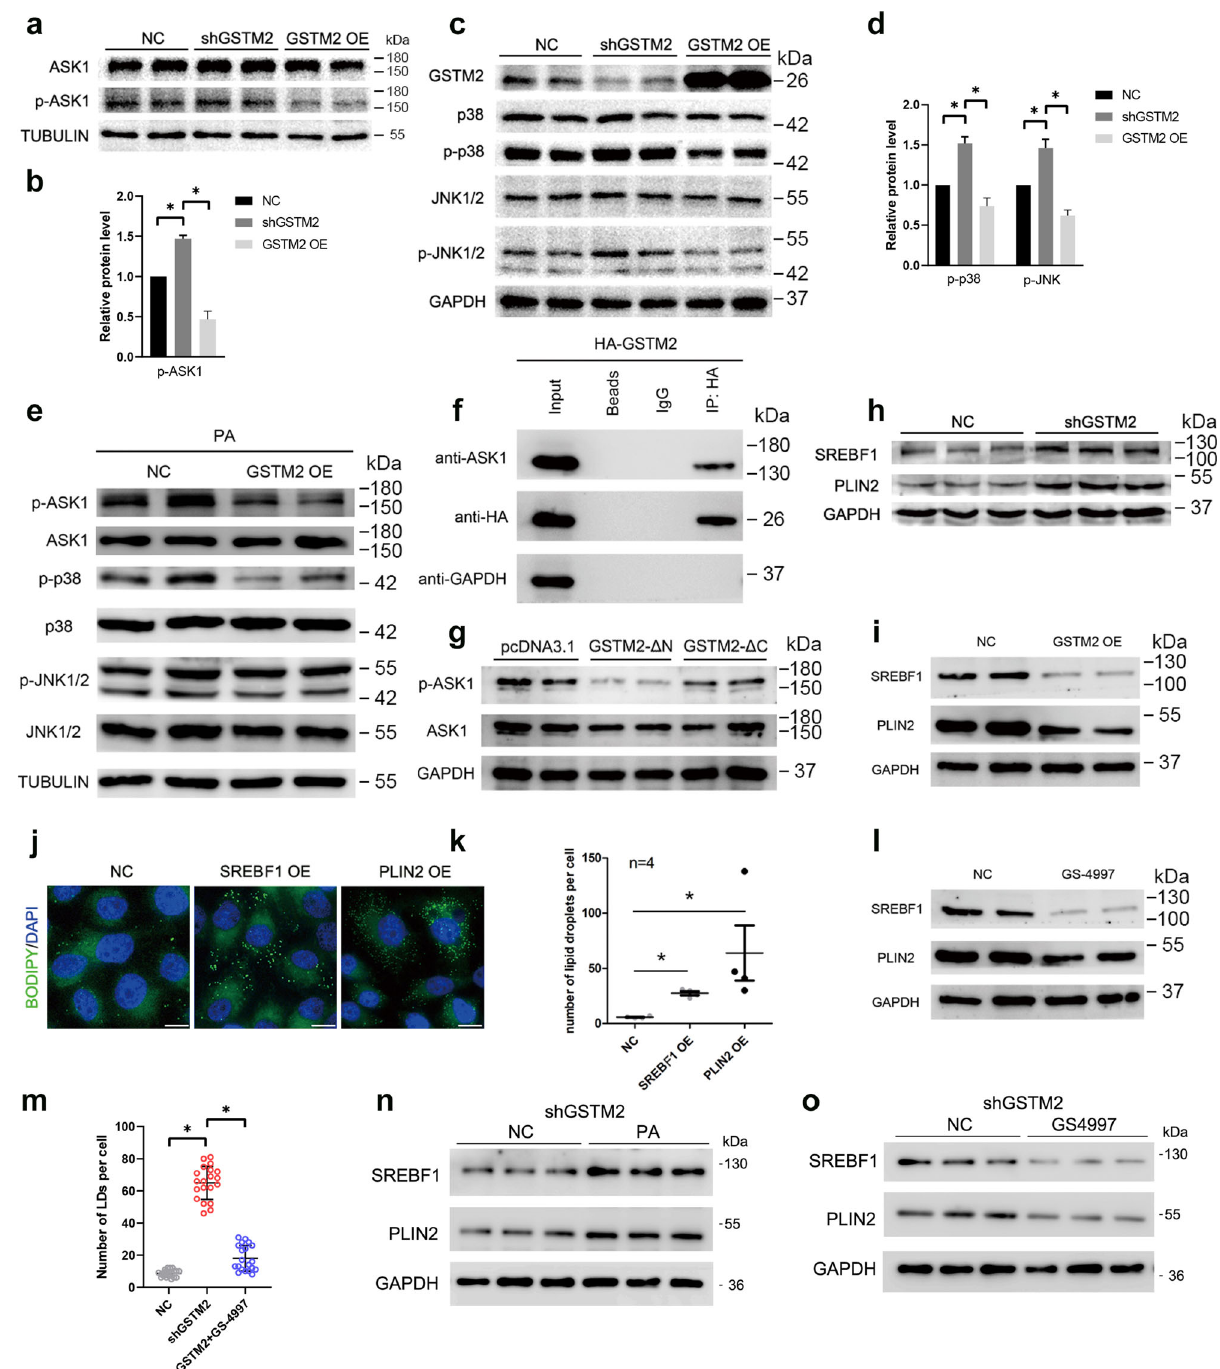
Fig. 4 GSTM2 regulated lipid droplet accumulation via ASK1-p38/JNK signalling. a , b Phosphorylation of ASK1 was up-regulated by GSTM2 KD and down-regulated by GSTM2 OE. c , d p-p38 and p-JNK levels were up-regulated by GSTM2 knockdown (KD) and down-regulated by GSTM2 OE. e GSTM2 OE down-regulated ASK1-p38/JNK signalling in the presence of palmitic acid treatment. f GSTM2 interacted with ASK1 by co-IP detection. g GSTM2 C-terminal, not N-terminal, down-regulated ASK1 activity. h SREBF1 and PLIN2 expression level was up-regulated by GSTM2 KD. i SREBF1 and PLIN2 expression level was down-regulated by GSTM2 OE. j More LDs were observed in cells with SREBF1 or PLIN2 overexpression. k Statistical analysis of number of LDs in cells with SREBF1 or PLIN2 overexpression. l Expression levels of SREBF1 and PLIN2 were down-regulated by GS-4997 treatment (ASK1 activity inhibitor). m Statistical analysis of number of LDs in shGSTM2 cells and shGSTM2 cells treated with GS-4997. n WB detection of SREBF1 and PLIN2 in shGSTM2 cells treated with PA. o WB detection of SREBF1 and PLIN2 in shGSTM2 cells treated with GS-4997. Bar, 10 μ GSTM2 KO mice (Fig. 6d). We then investigated the protein level of ASK1-p38/JNK signalling pathway. As expected, the levels of p-ASK1, p-p38 and p-JNK in the GS-4997 treatment group were decreased signi fi cantly ( p < 0.05) (Fig. 6e, f).